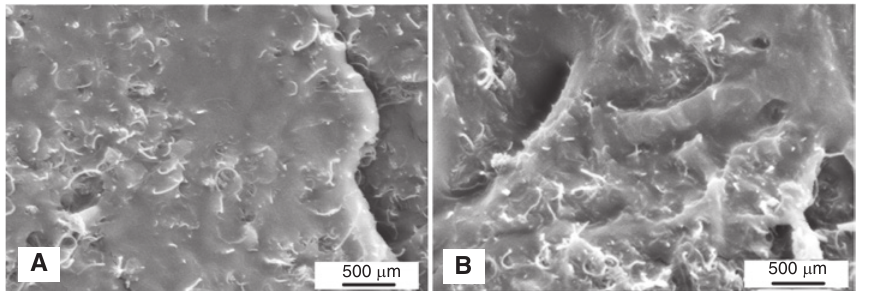
Figure 9: Scanning electron microscopy images of PLA/MWCNT composites with 5wt.% MWCNTs: rolling ratios of (A) 0% and (B) 60% (paral- lel to rolling